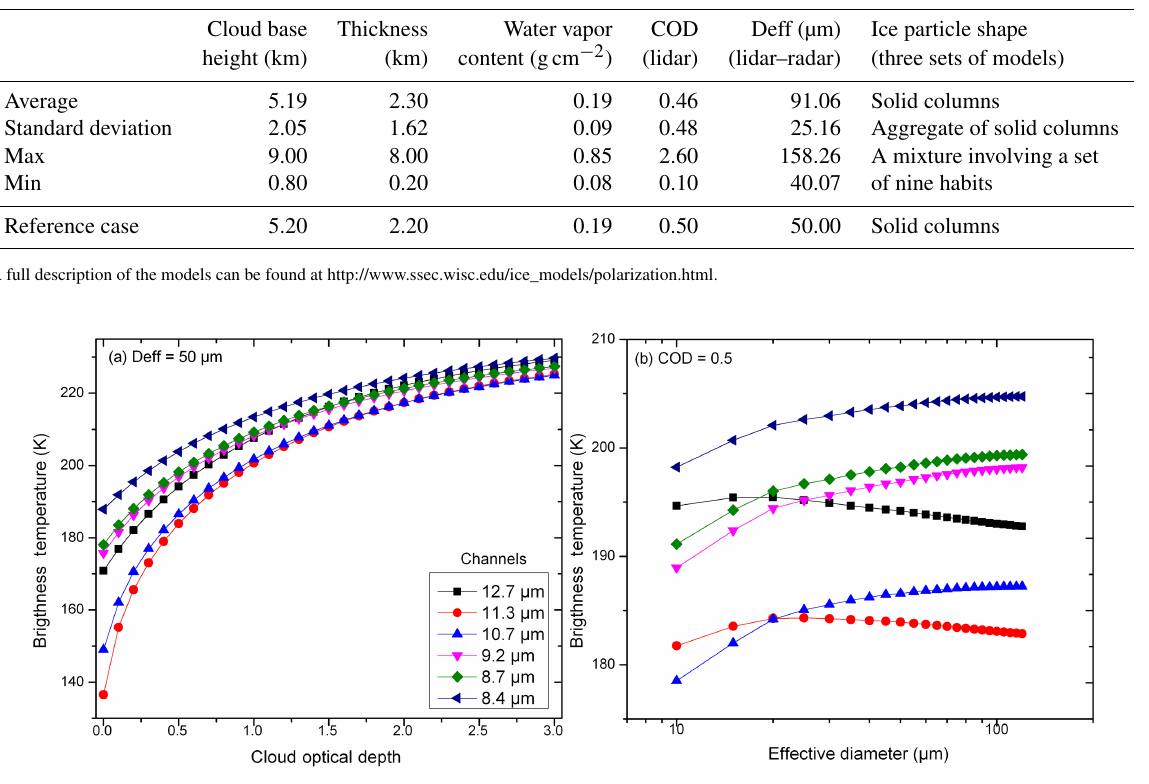
Table 2. Average, standard deviation, maximum and minimum values of the parameters of the cloud cases used in this study. The reference case, defined in the last row, was employed to produce Fig. 3 (while varying D eff and the COD) and was used for the sensitivity study of Fig. 4. The means, standard deviations and extrema of each parameter were derived from our analysis of the 150 cloud cases. For the reference case, the cloud base height and thickness values were, for the sake of convenience, rounded to the nearest incremental step of the MODTRAN vertical layer profiles.